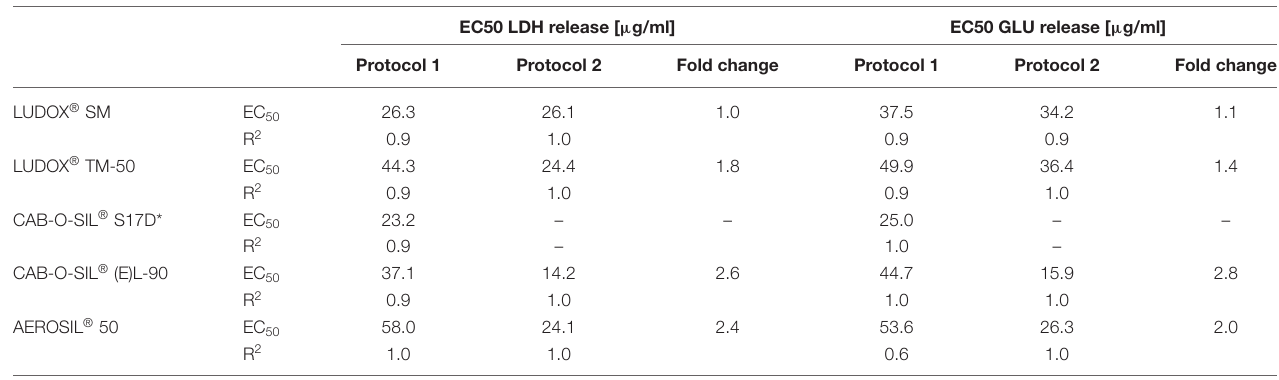
TABLE 4 | EC 50 values of LDH and GLU release obtained with Protocol 1 or